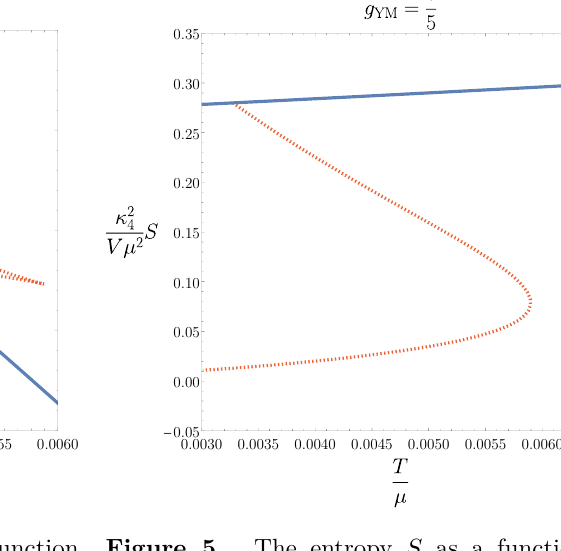
Figure 4. The grand potential Ω as a function of temperature for both normal (blue) and con- densed (red, dashed) phase with g YM = 3 / 5 . The condensed phase curve exhibits swallow tail be- haviour, and the intersection between it and the normal phase curve shows that Ω is continuous, but non-differentiable. This is characteristic of first order phase transition.